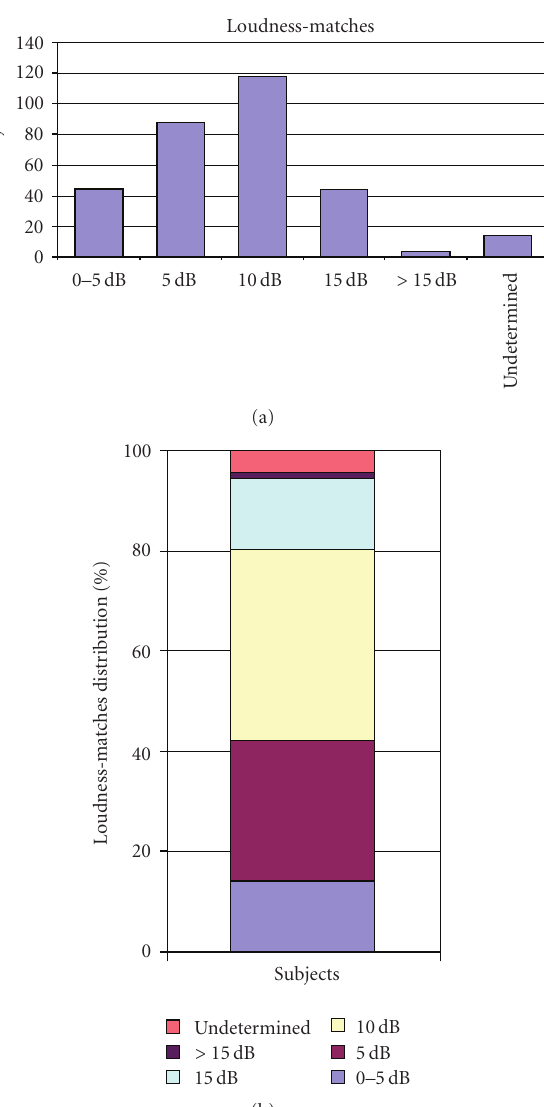
Figure 2: Distribution of the loudness matches: (a) absolute values; (b) relative values.